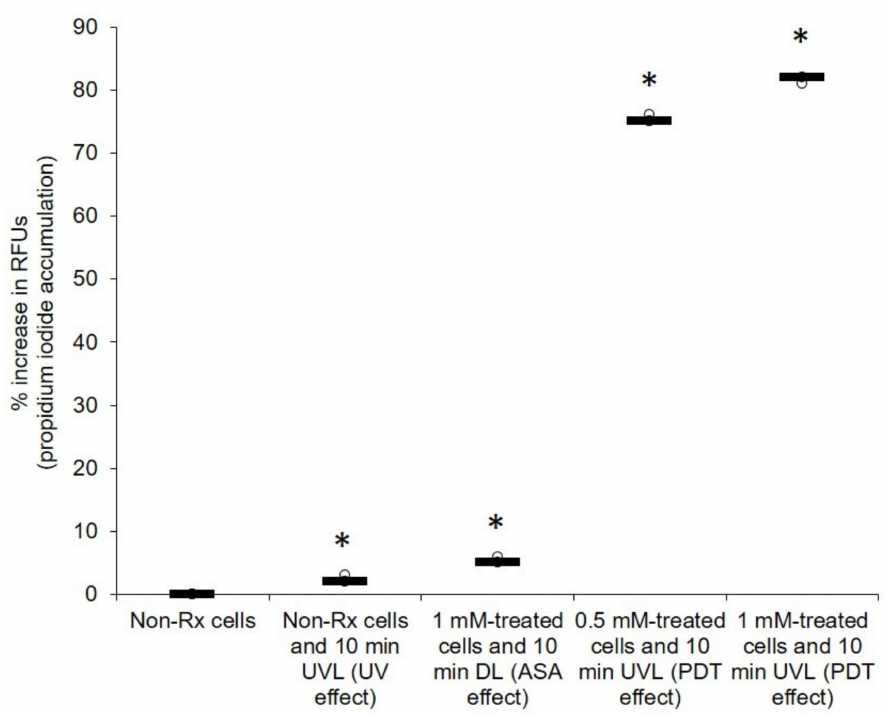
Figure 3. PDT action of ASA showing that cells of C. neoformans LMPE 046 lost their selective permeability. The background signal of negative controls was used for normalisation. There was a normality of data distribution. Non-Rx, non-treated cells; UVL, ultraviolet light; DL, dark light; RFUs, relative fluorescence units. Data points were obtained from three biological replicates for each defined experimental condition. * Significantly different from non-Rx cells at p < 0.05.